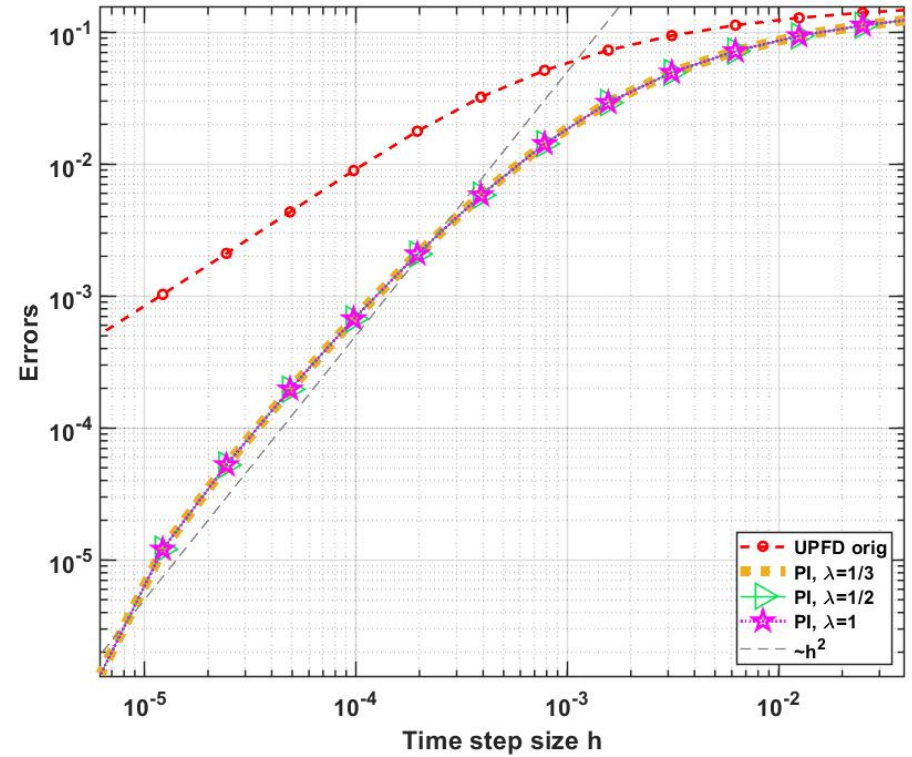
Figure 2. The L ∞ errors as a function of time step size h for the numerical solutions of Equation (1) in case of Algorithm 2 and the new pseudo-implicit Algorithm 4 for three different values of parameter λ . This parameter causes only very slight differences, thus the three curves almost coincide.